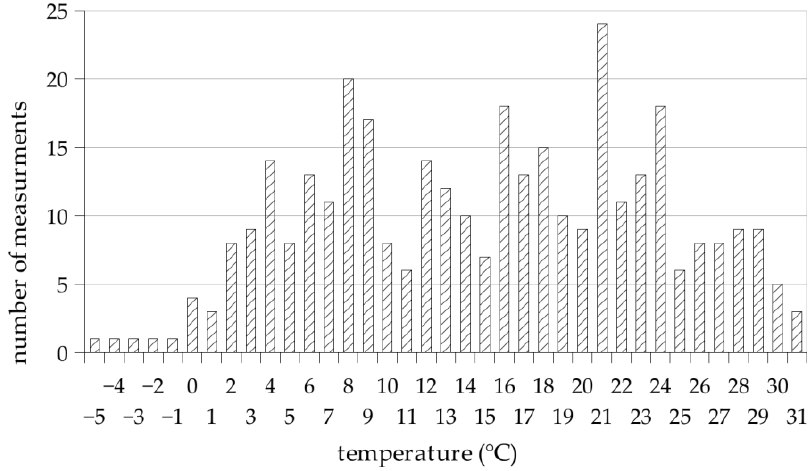
Figure 1. Distribution of measurement points (M T —test, M L —learning) in the space of temperature T and insolation G, T × G.